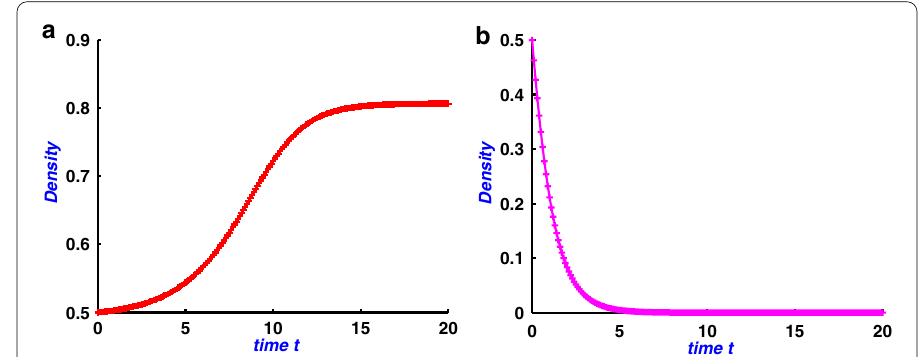
1, u 0 0.5 with a 0 < M = =